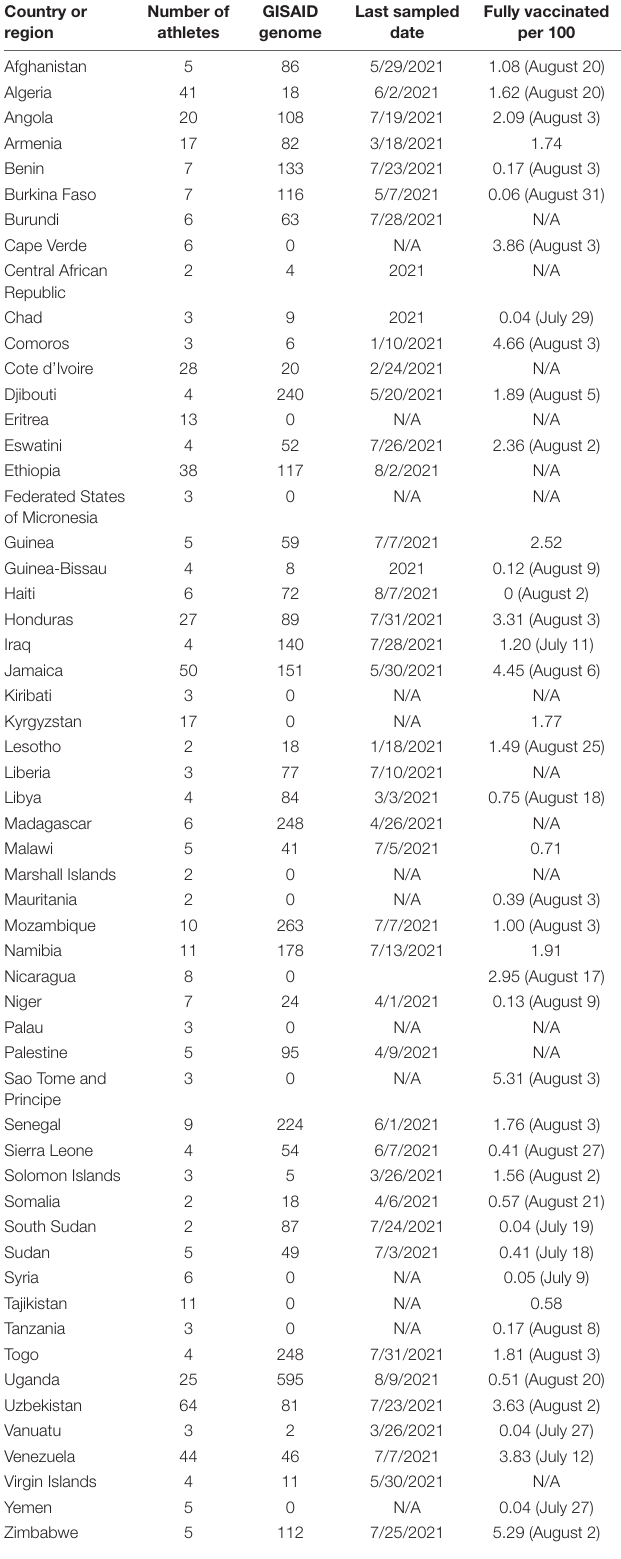
TABLE 2 | List of Countries with vaccination rates lower than 10% on the August 1st otherwise noted, whose SARS-CoV-2 genomes have not been updated since the Olympic and Paralympic Games. Country or Number of region